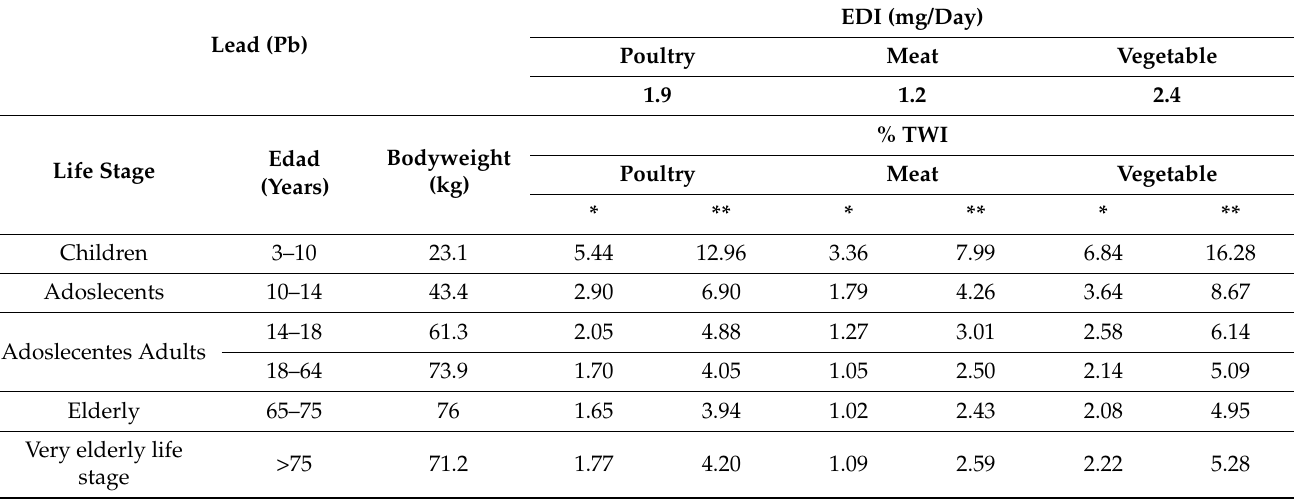
Table 8. Estimated daily intake and contribution percentage to the Pb BMDL (* Cardiovascular effects, ** Nephrotoxic